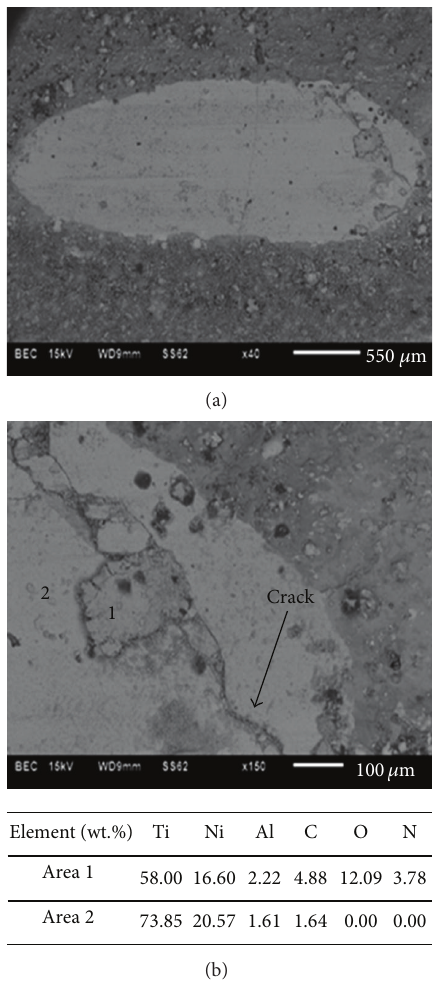
Figure 12: Wear track of the laser deposited Ni45Ti55 after sliding against a tungsten carbide ball under dry conditions.